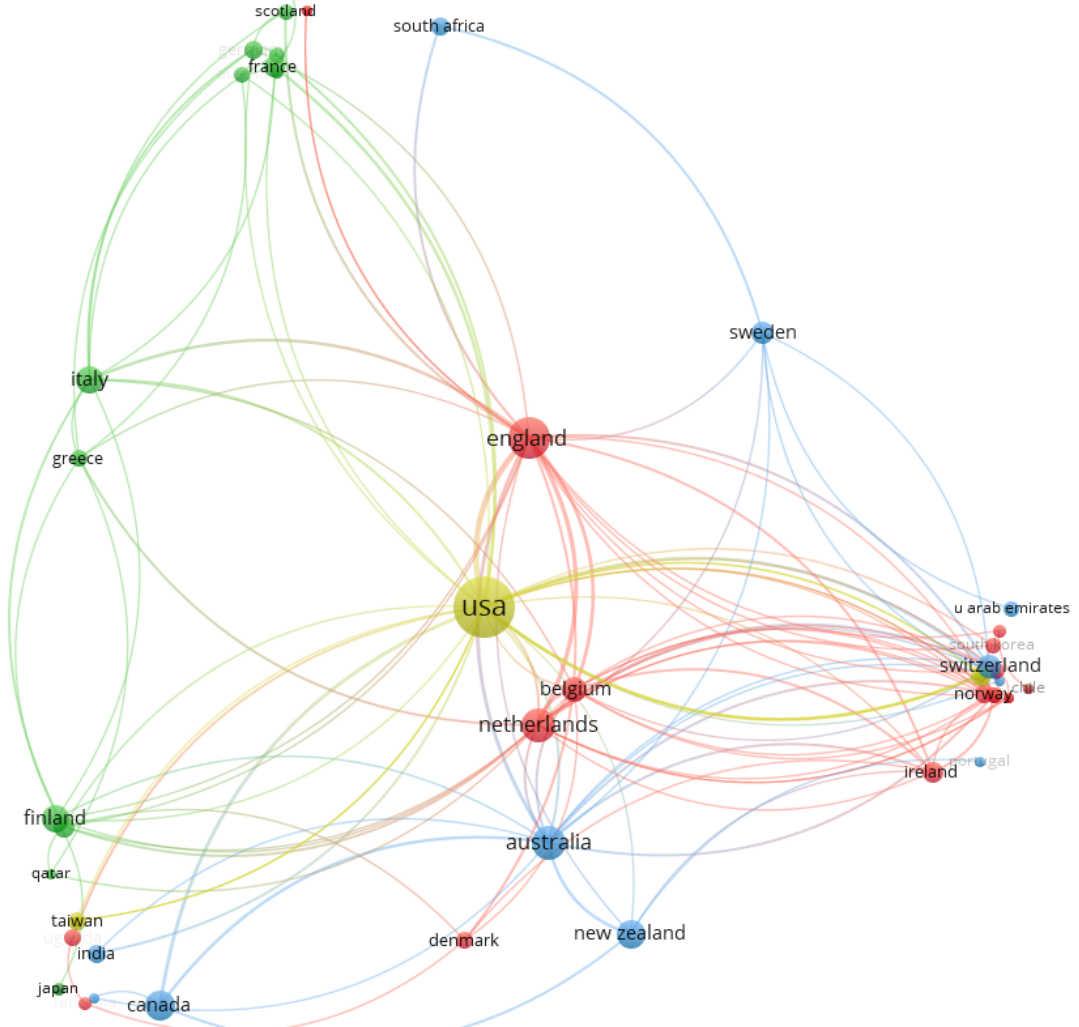
Figure 6. Countries collaboration